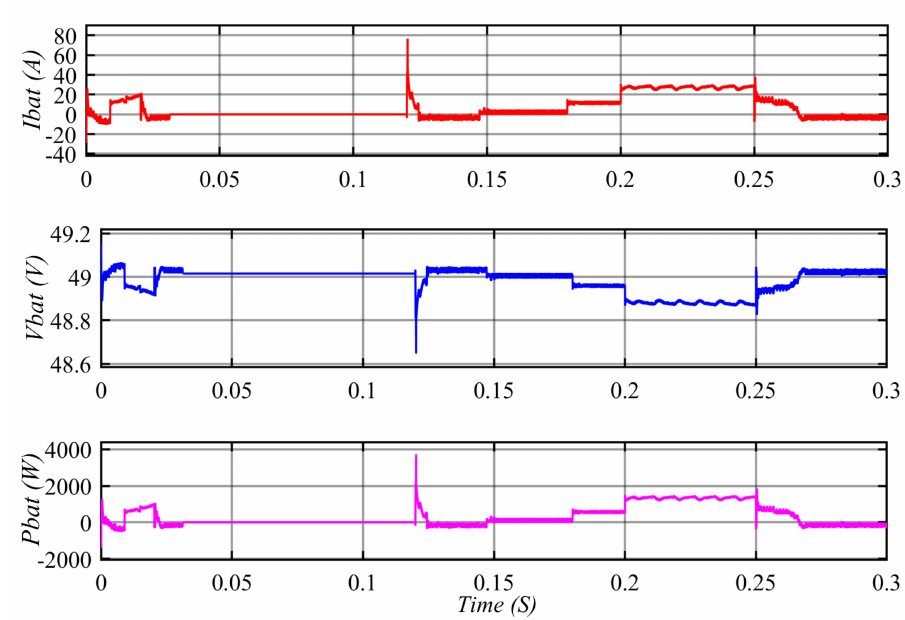
Figure 16. Changes in the battery’s current, voltage, and power under load constant and radiation